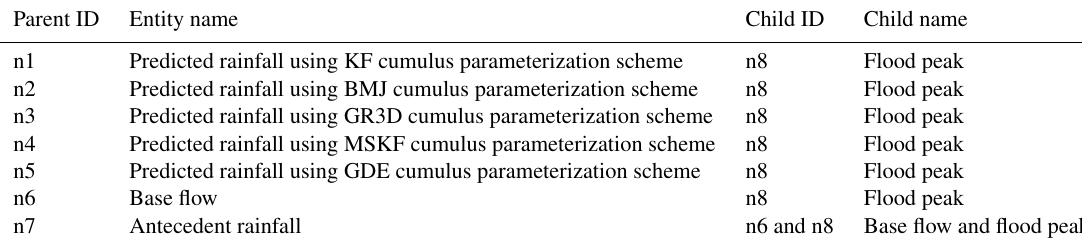
Table 4. The cause–effect relationships among the variables in the proposed structure of the Bayesian network. Parent ID